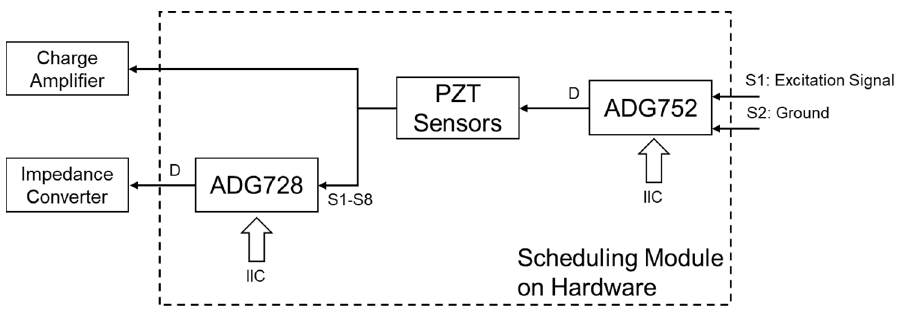
Figure 3. Hardware description of the scheduling module.